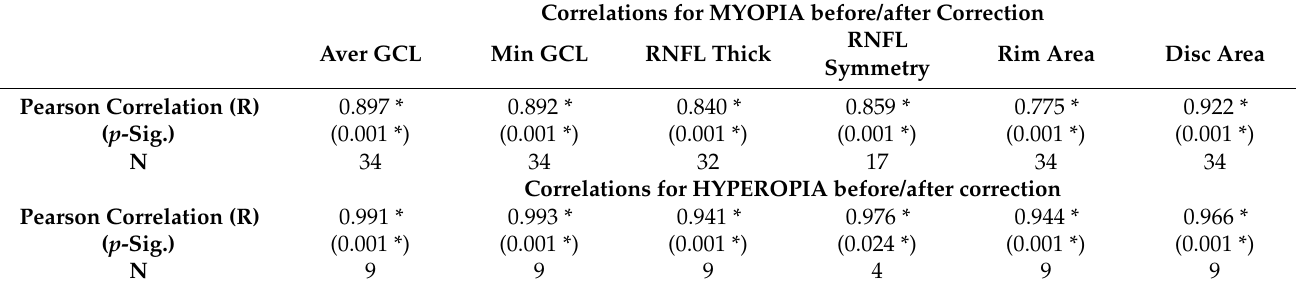
Table 2. Correlative analyses of the selected pairs before and after correction; N: number of cases; p < 0.05 marked with *